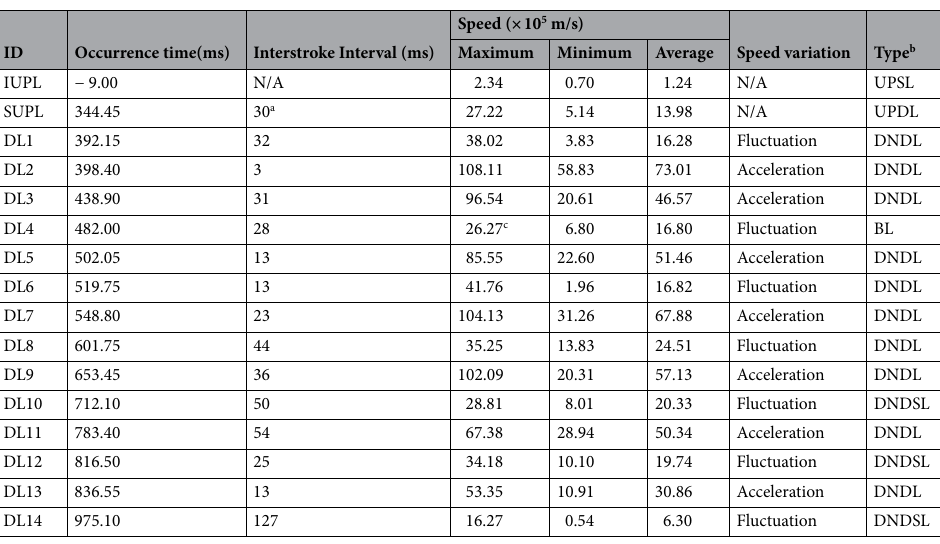
Table 1. Characteristics of the sixteen leaders in F1907021515. a Interstroke Interval of SUPL is the interval between the occurrence of SUPL and the end of the last ICCP, instead of a RS. b UPSL: upward positive stepped leader; UPDL: upward positive dart leader; DNDL: downward negative dart leader; BL: bidirectional leader; DNDSL: downward negative dart-stepped leader. c The speed of DL4 represents the speed of its downward